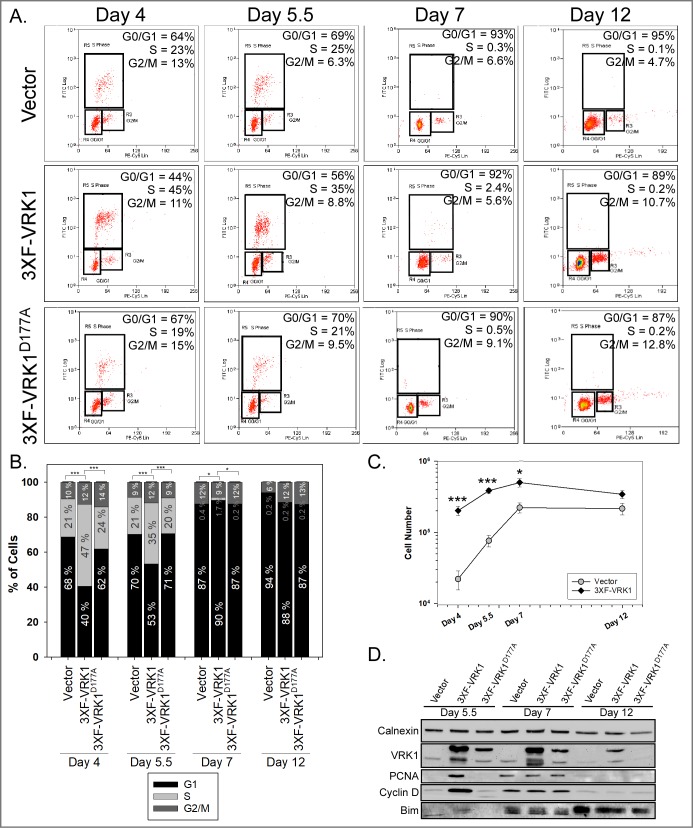
VRK1 overexpression in MCF-10A cells augments cell proliferation during the initial stages of acinus formation.(A) Cell cycle analysis was performed on control, 3XF-VRK1-overexpressing and 3XF-VRK1D177A-overexpressing MCF10a acinar cells harvested at days 4, 5.5, 7 and 12 of 3D matrigel culture. BrdU-pulsed cells were stained with anti-BrdU and propidium iodide and analyzed by flow cytometry. Representative flow data is shown, with the percentage of cells in G0/G1, S and G2/M shown in the top right of each panel. (B) Quantification of the percentage of cells that were in G0/G1 (black bar), S (gray bar), and G2/M (dark gray bar) at different time points (mean and standard error shown; *p <0.05; ***p < 0.001) (n = 3). (C) Plot of the total cell number in control or 3XF-VRK1-overexpressing acini harvested at days 4, 5.5, 7 and 12 of 3D culture (mean and standard error shown; *p<0.05, ***p<0.001) (n = 3). (D) Immunoblot analysis of control, 3XF-VRK1-overexpressing and 3XF-VRK1D177A-overexpressing MCF10a acinar cells harvested at days 5.5, 7, and 12 of 3D culture. Representative blots are shown (n = 2).